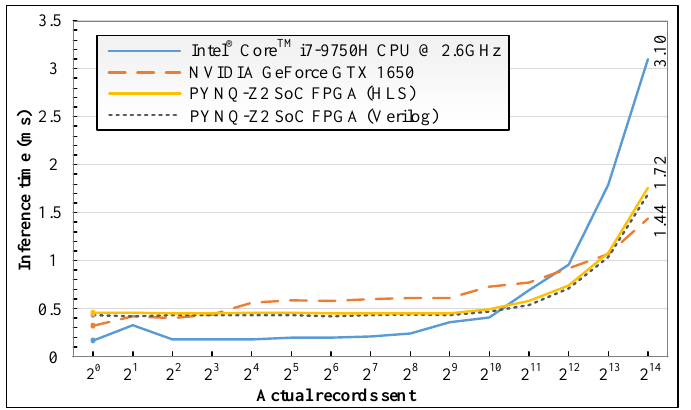
Figure 10. The CPU, GPU, and FPGA inference times for different input buffer sizes.